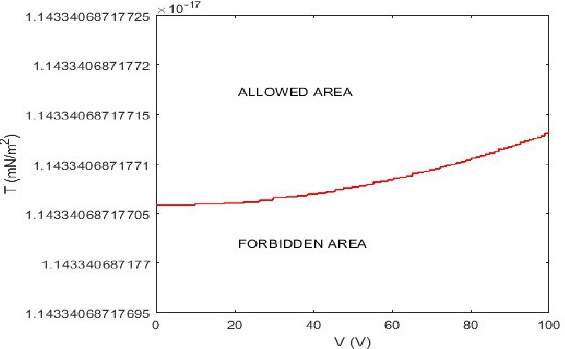
Figure 8. Graphic representation of (52) to highlight the ( V , T ) pairs that allow numerical recovery.